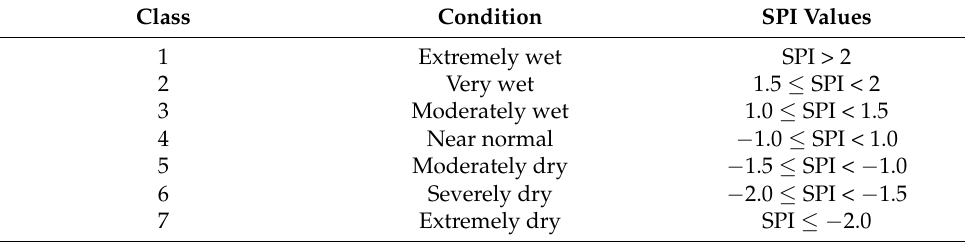
Table 2. Classification scale for the SPI values